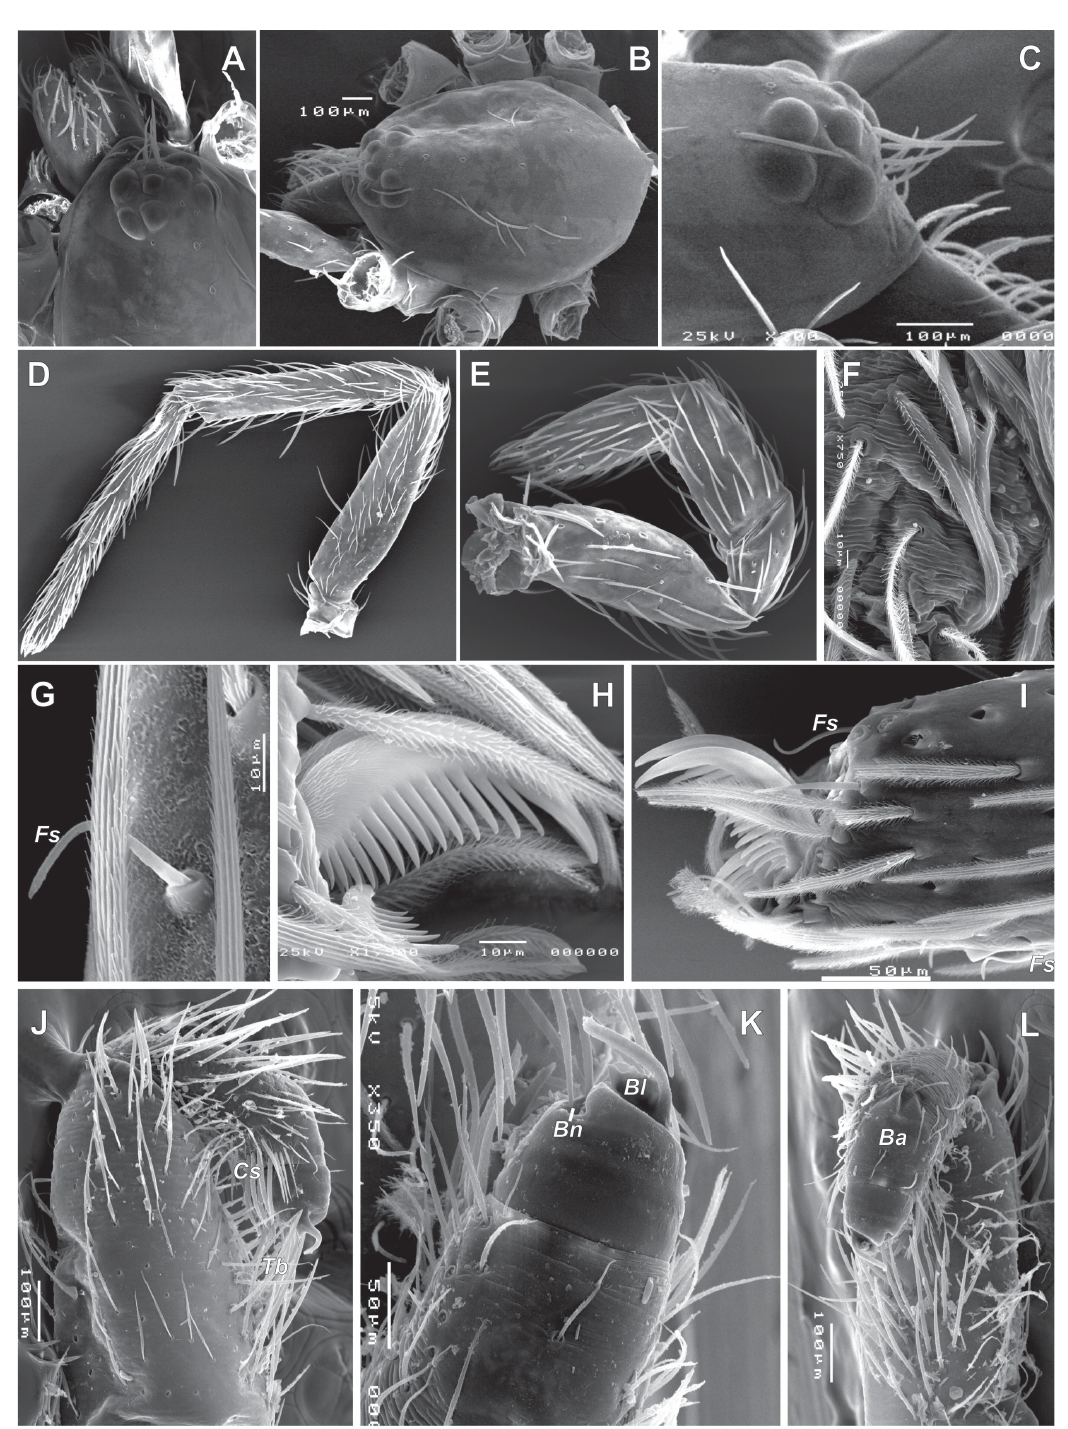
Fig. 1. Morphology of Zaitunia . A–C . Z. martynovae (Andreeva & Tyshchenko, 1969), subadult ♀ from Gandzhina. D–I . Same, adult ♀. J – L . Z. logunovi sp. nov., paratype, ♂. — A , C . anterior part of prosoma, dorsal and lateral. B . Prosoma, dorsal. D . Leg iV, prolateral. E . Palp, prolateral. F . Cuticle and setae covering venter of abdomen. G . Leg surface showing large and fine (possibly chemosensory) setae. H–I . tarsal claws of leg iV, prolateral. J – L . terminal part of palp, prolateral, dorsal and ventro- retrolateral. abbreviations: see Material and